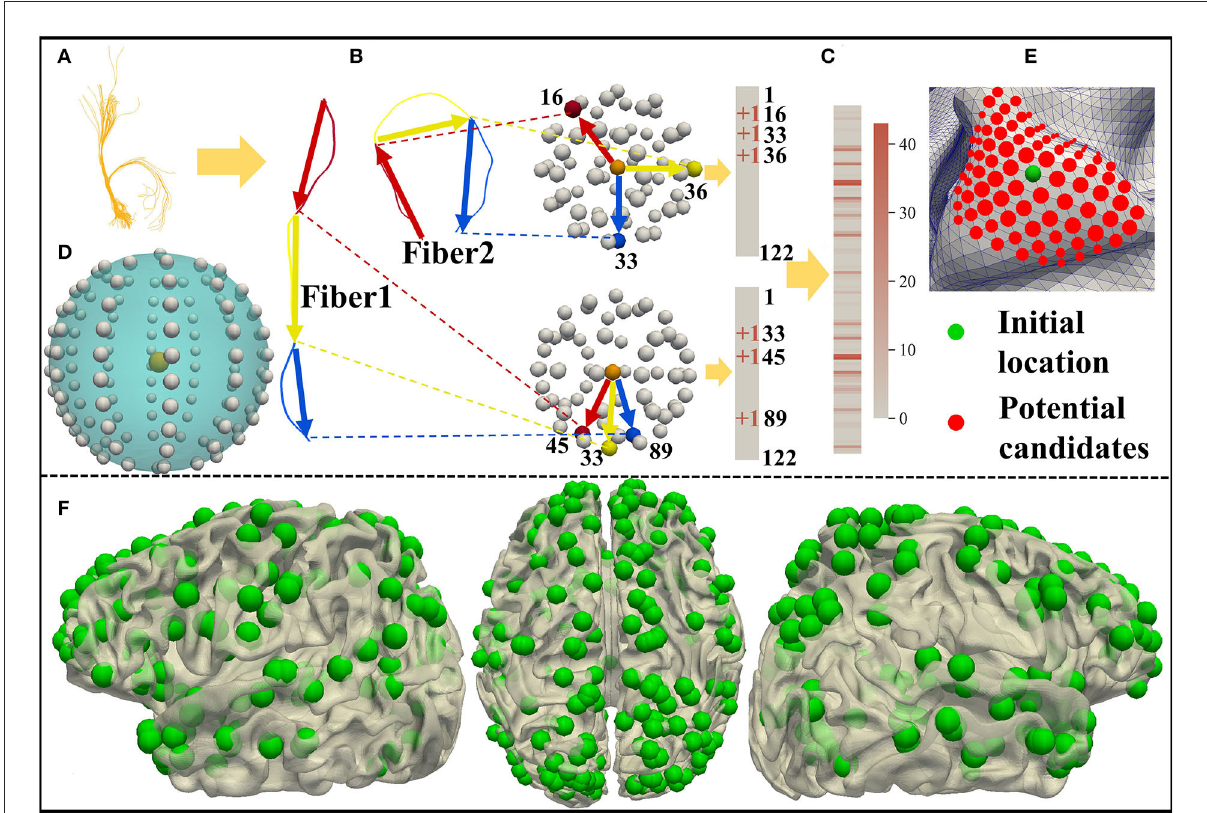
FIGURE2 (A) A bundle of fibers passing through the DICCCOL landmark. (B,C) Trace-map approach. (D) Sphere containing 122 regions. (E) Initial location and potential candidates of DICCCOL landmark. (F) DICCCOL landmarks on one term subject visualized from three perspectives of the left hemisphere, medial view, and right hemisphere.